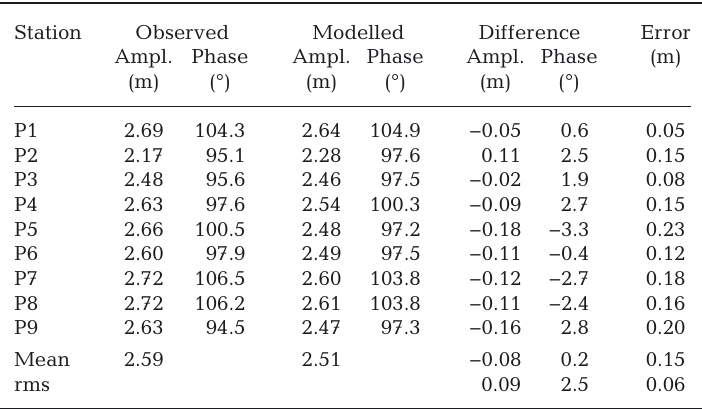
Table 2. Observed and modelled amplitude and phase, and discrepancies of